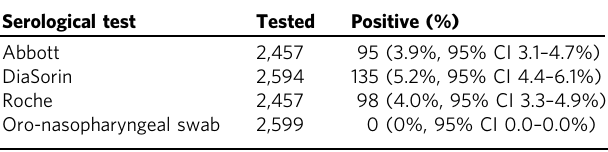
Table 2 Tested individuals and positivity rates for the different assays in the Vo ’ cluster in May